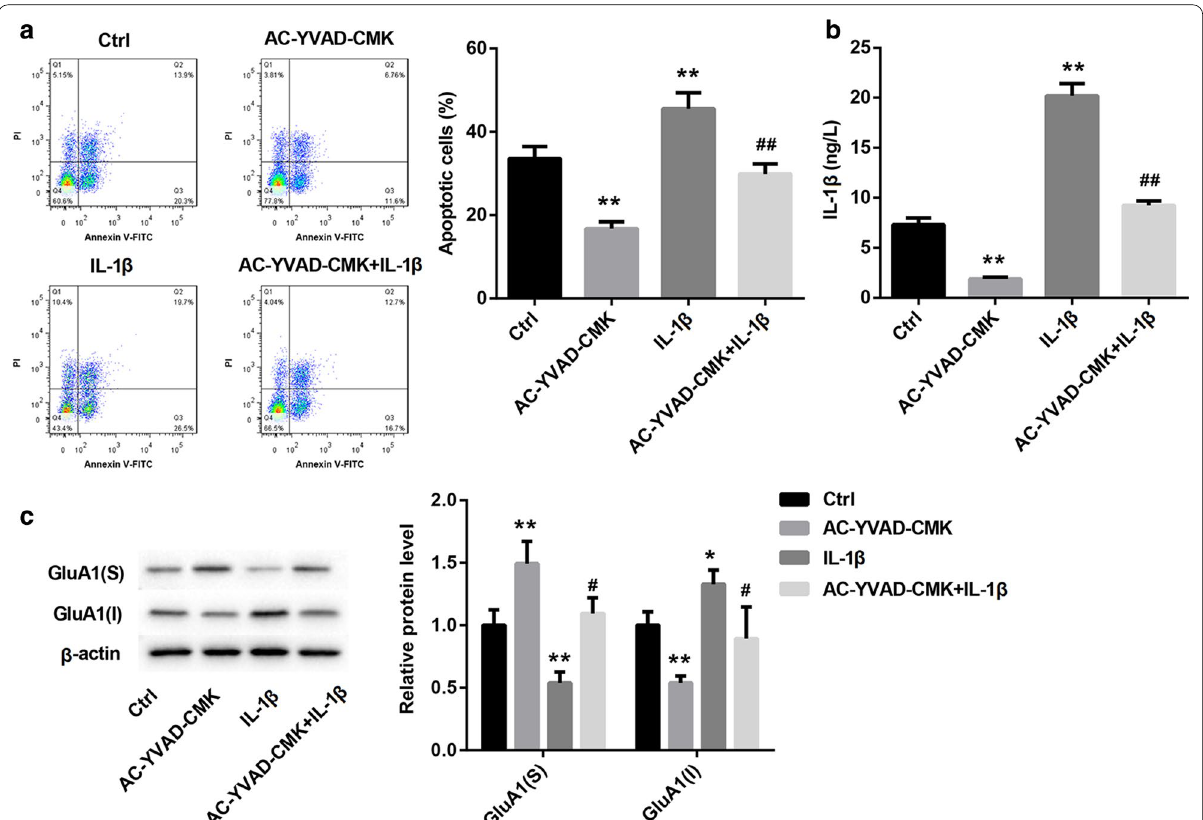
Fig. 4 Caspase-1/IL-1β promoted apoptosis and inhibited membrane transport of GluA1 in Aβ 1-42 -induced hippocampal neurones. Hippocampal neurones were treated with